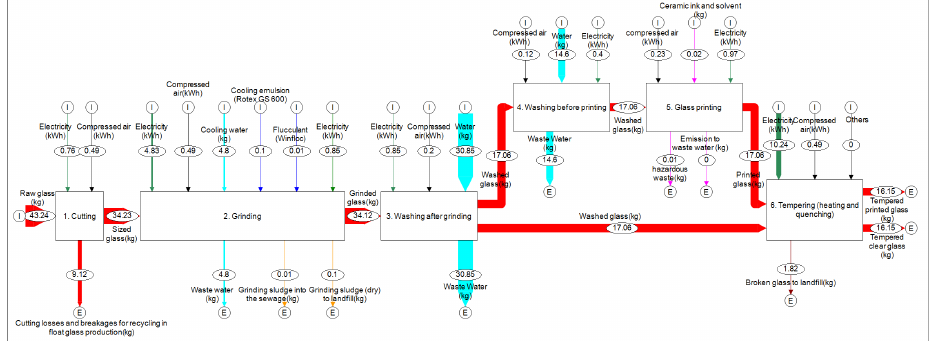
Figure 4. Material (kg) and energy (kWh) flows to produce 1.615 m 2 of a multi-coloured and a clear solar glass sheet with 4 mm thickness at a Swiss glass supplier. Arrowheads labelled I denote import flow, indicating an input material or energy, while those labelled E denote export flow, indicating a product, waste, or loss. The data was derived from the material and energy balance as well as the measured electricity consumption of the production steps and support processes. These were obtained from the Swiss glass manufacturer (courtesy of Glas Trösch AG,